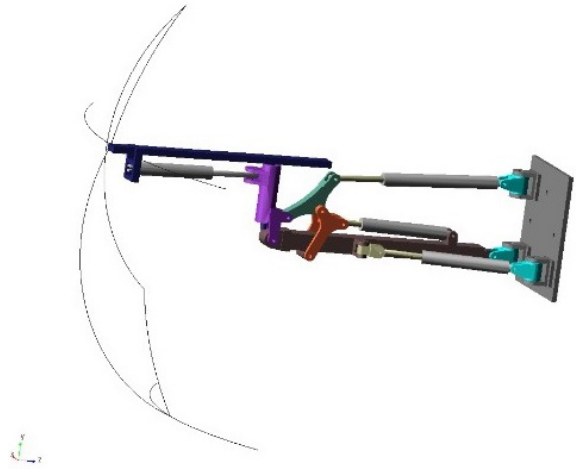
Figure 6. Simulation model of a new